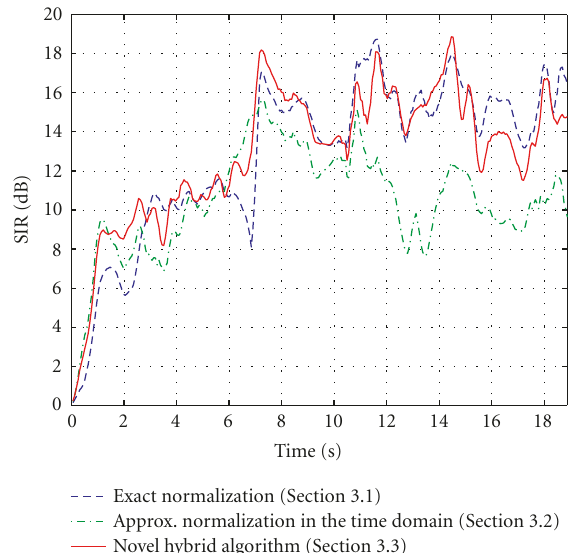
Novel hybrid algorithm (Section 3.3) Figure 2: SIR results for reverberant room.